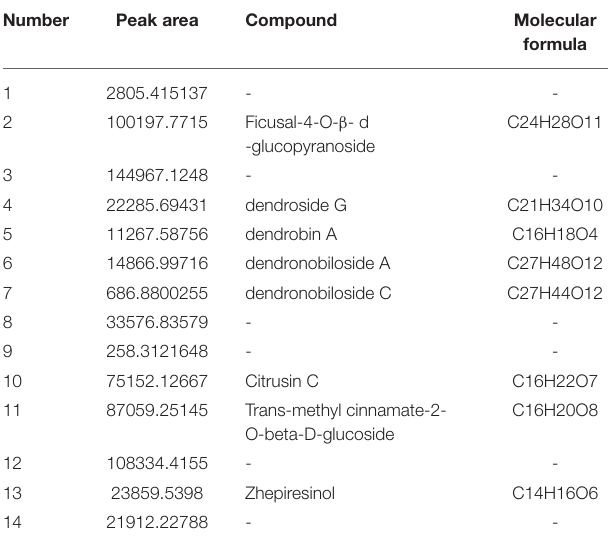
TABLE 1 | Chemical profile of Dendrobium nobile extract